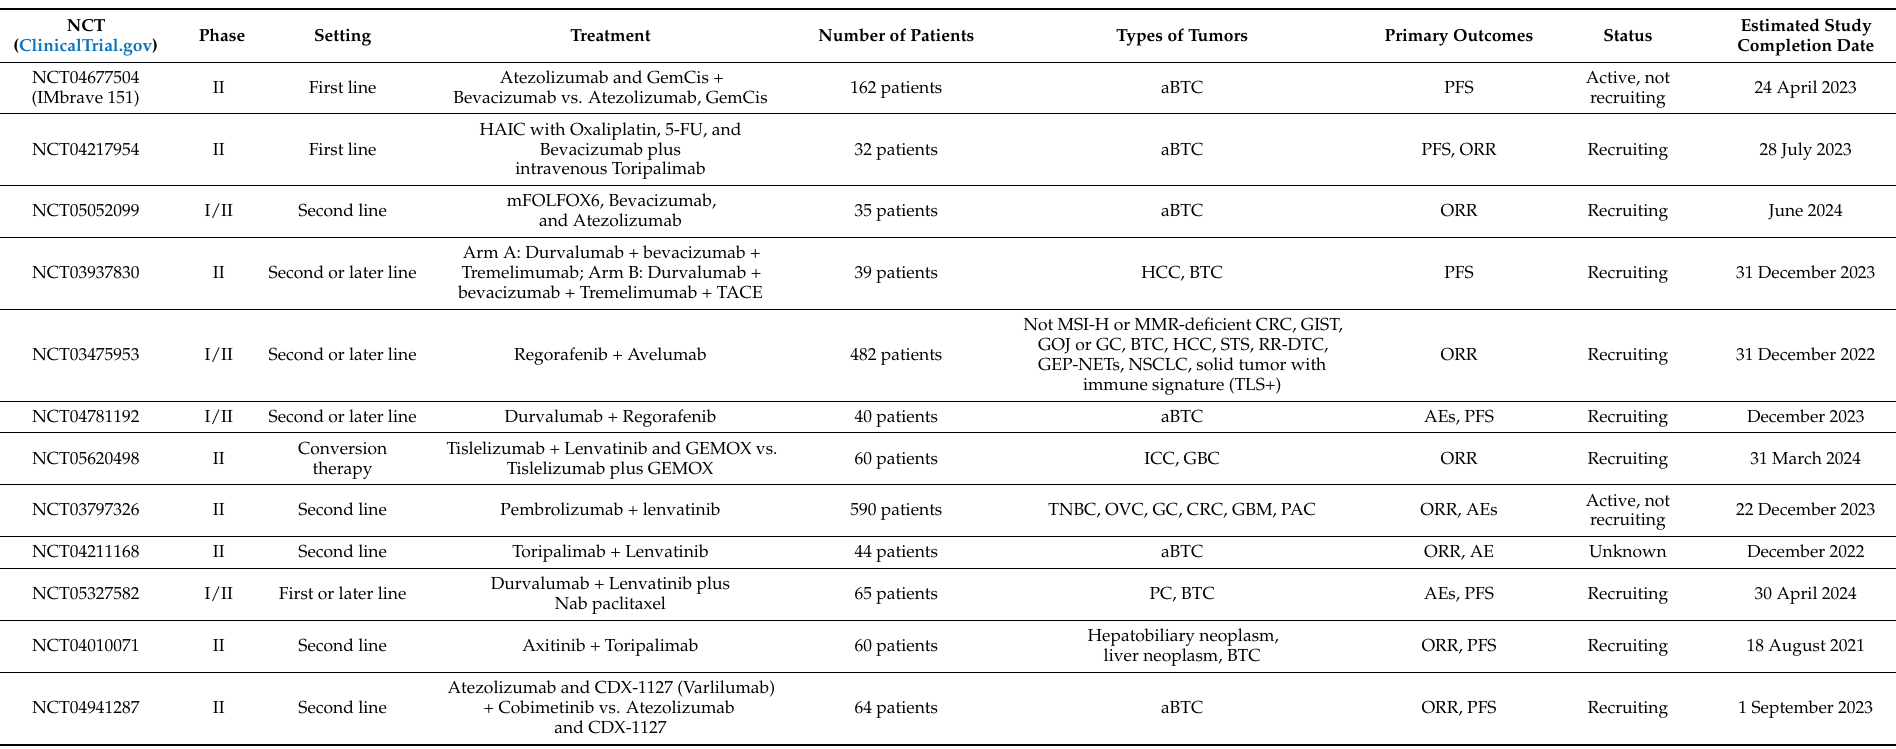
Table 2. Comprehensive table of ongoing trials evaluating immunotherapy in combination with antiangiogenic therapy in biliary tract cancer. Ongoing clinical trials were identified and selected by searching ClinicalTrials.gov. Abbreviations: aBTC, advanced biliary tract cancer; HCC, hepatocellular carcinoma; CRC, colorectal cancer; GIST, gastrointestinal stromal tumor; GOJ, gastroesophageal junction carcinoma; GC, gastric cancer; STS, soft-tissue sarcoma; RR-DTC, radioiodine-refractory differentiated thyroid cancer; GEP-NETs, neuroendocrine gastroenteropancreatic tumors; NSCLC, non-small cell lung cancer; ICC, intrahepatic cholangiocarcinoma; GBC, gallbladder cancer; TNBC, triple-negative breast cancer; OVC, ovarian cancer; GBM, glioblastoma biliary tract cancer; PAC, pancreatic cancer; PFS, progression- free survival; ORR, overall response rate; RP2D, recommended phase 2 dose; AEs, adverse